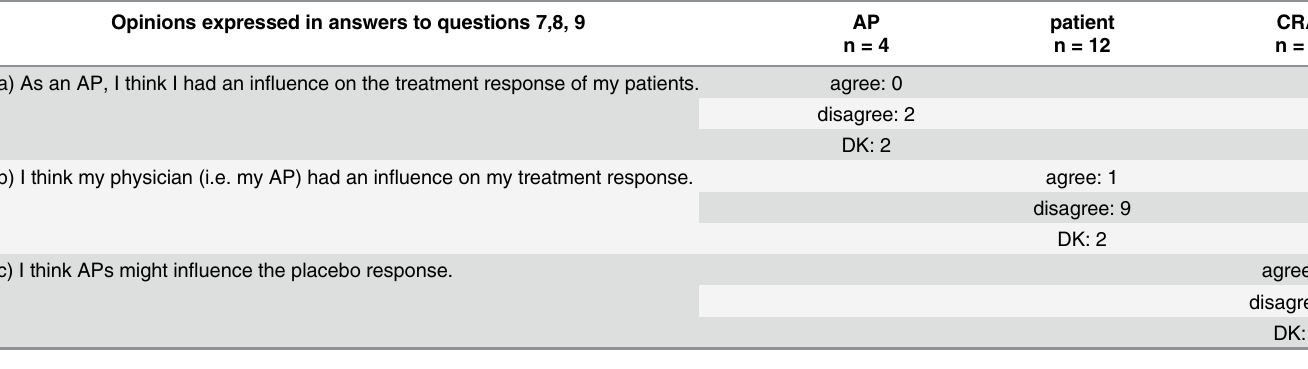
Table 6. Specific influence of APs on treatment response of their patients. Opinions expressed in answers to questions 7,8, 9 AP patient CRA n = 4 n = 12 n =